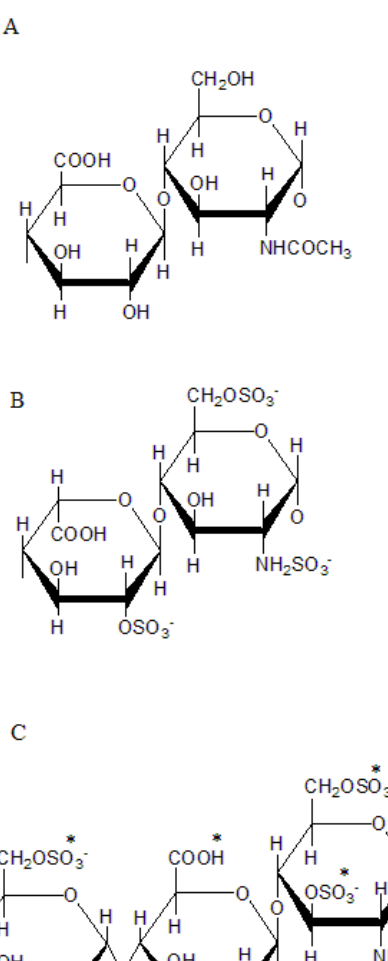
An Acad Bras Cienc (2005) 77